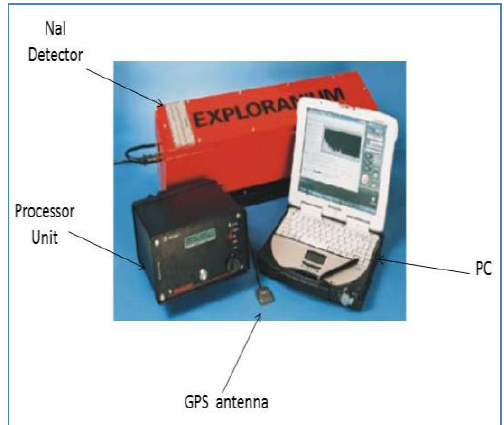
Fig. 2: Photo of GR-460 mobile detection.